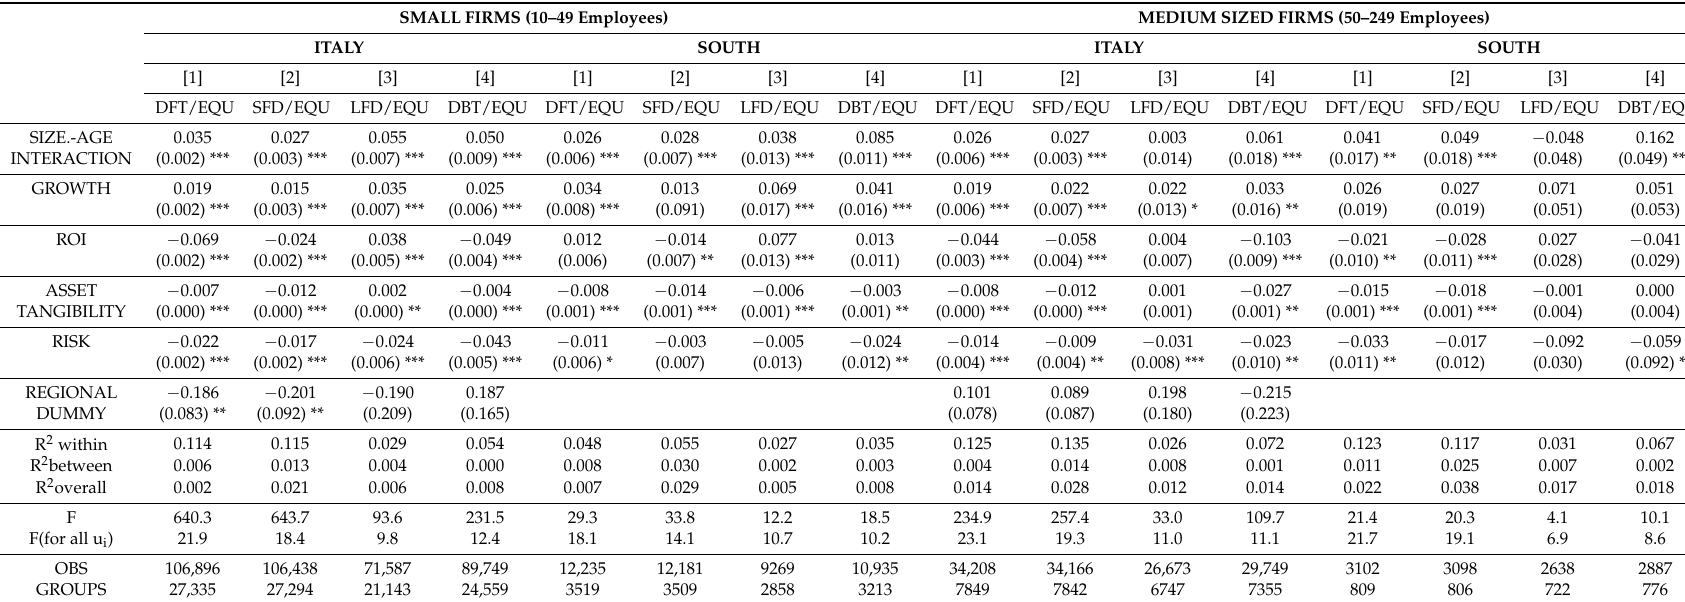
Table 6. Panel estimation (2001–2013 years) for small and medium sized firms (all variables expressed as natural logarithm). SMALL FIRMS (10–49